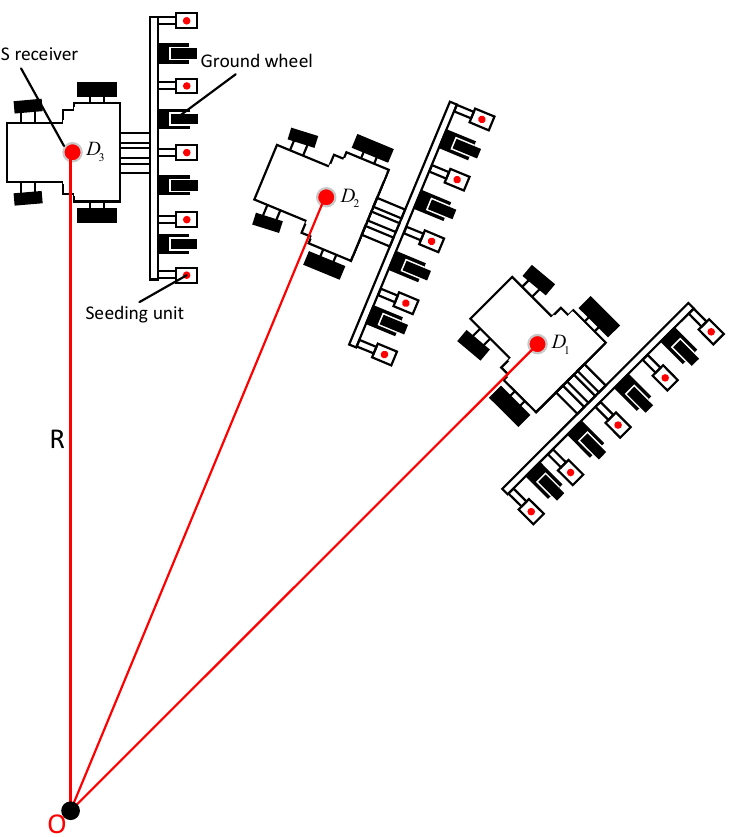
Figure 3. Tractor Steering Diagram.